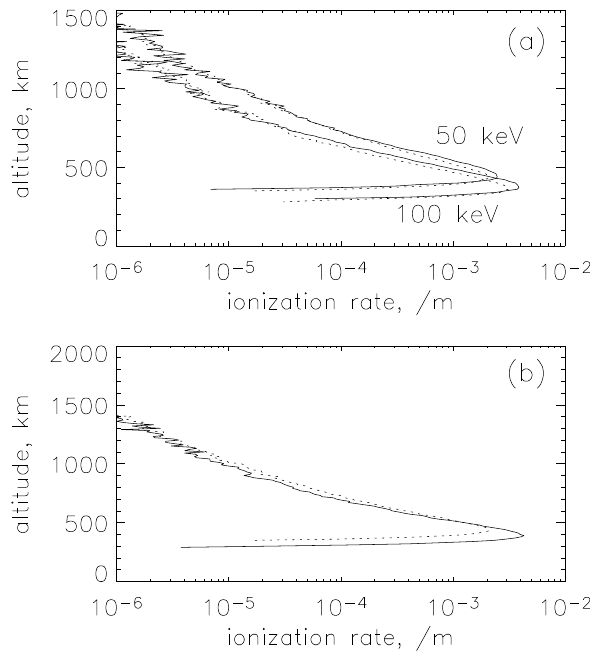
Figure 2: 2007.12.18: Y. Hiraki and C. Tao Fig. 2. (a) Effect of electron-helium collision on the total ioniza- tion rate for the cases of ε 0 = 50 and 100keV. The solid and dotted curves are calculated with and without including He, respectively (see text for the detail of He parameters). (b) Effect of uncertainty in electron-hydrogen electronic excitation cross sections for the case of ε 0 = 50keV. Dotted line is the original one, while the solid line is the result modified (see